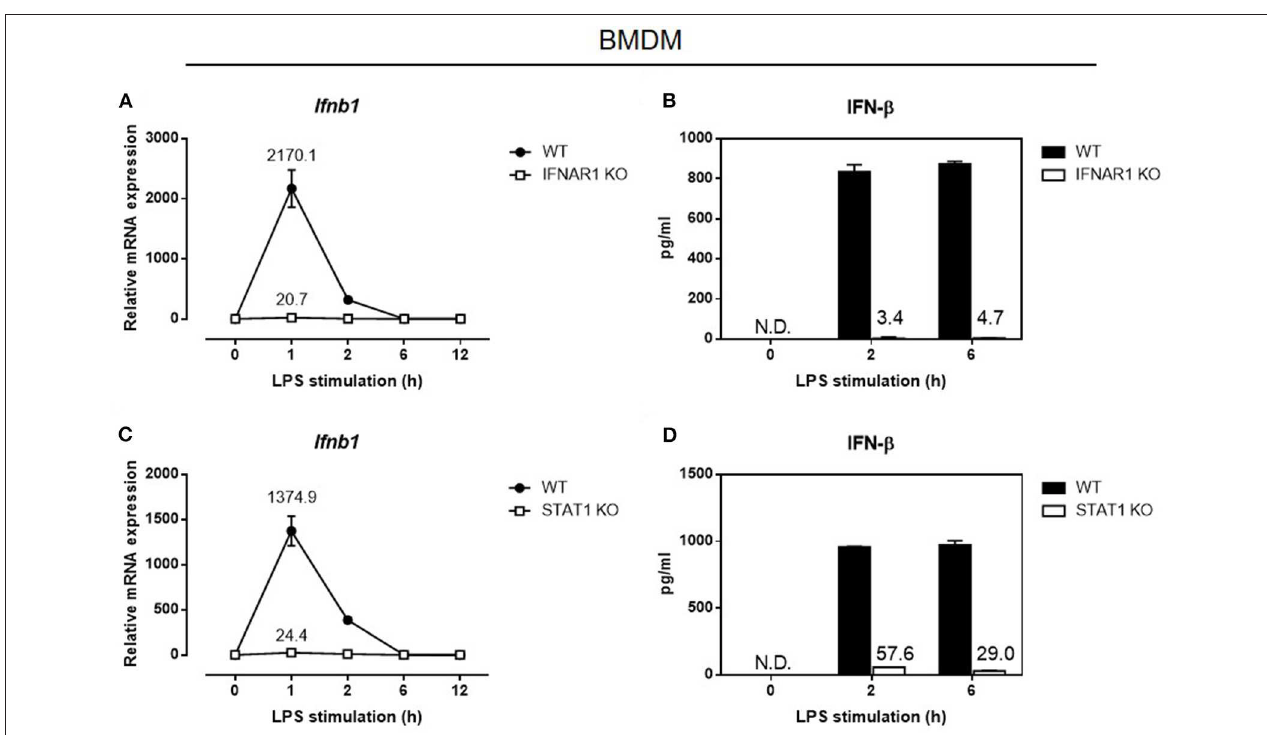
FIGURE 5 | Autocrine/paracrine IFNAR1-STAT1 signaling is required for IFN- β gene and protein expression in LPS-challenged macrophages. Real-time PCR and ELISA analysis of IFN- β gene and protein expression of BMDMs from IFNAR1 knockout mice (A,B) , and STAT1 knockout mice (C,D) , compared to wild-type control littermates, stimulated or not with 100ng/ml LPS for 0–12h. Ifnb1 expression was normalized to Gapdh and expressed relative to the levels observed in un-stimulated wild-type control cells. Data are presented as mean ± SD of duplicate determinations from one representative of at least three independent experiments (N.D.: not